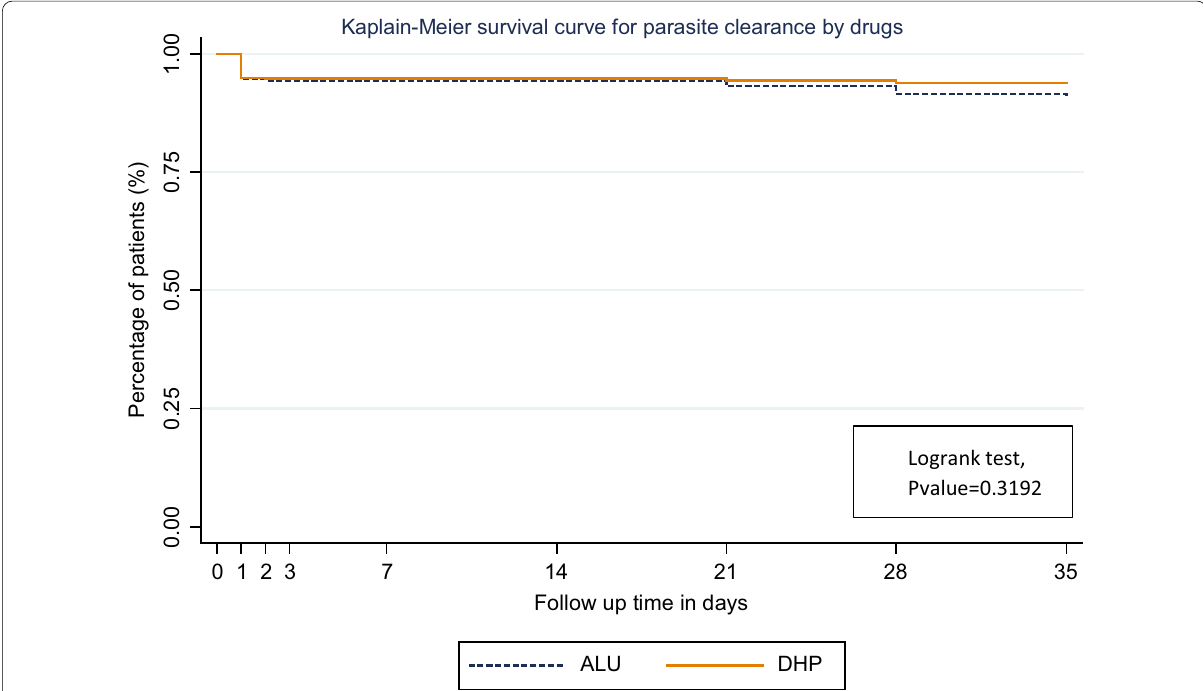
Fig. 1 Cumulative risk of recurrent parasitemia by 35 following treatment with artemether–lumefantrine and dihydroartemisinin–piperaquine– Cox-proportional hazards risk